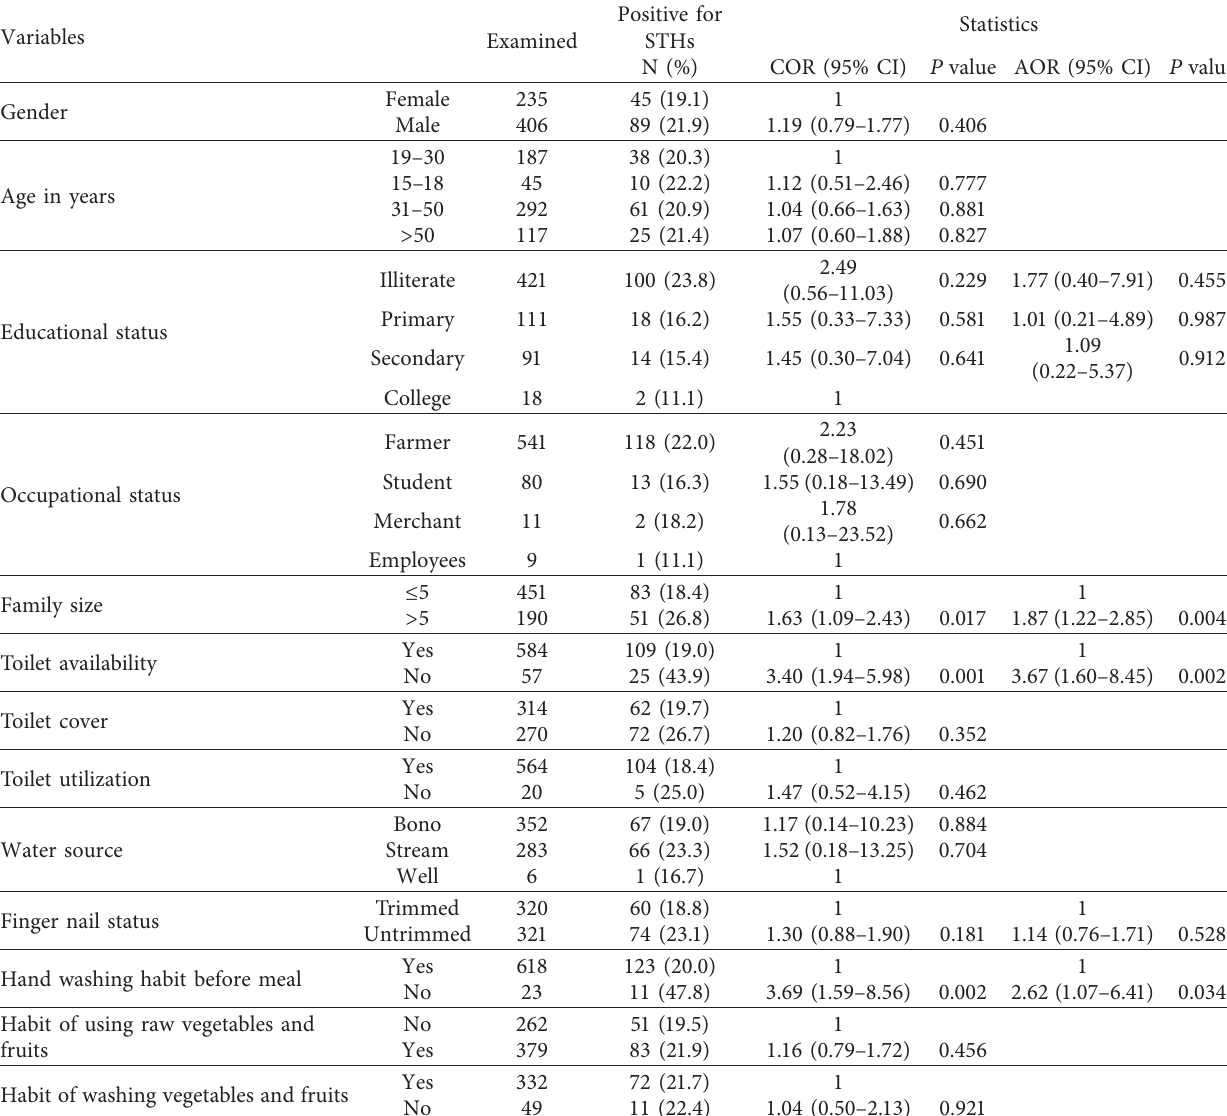
Table 4: The possible potential factors associated with STH infections among adolescents and adults ( n � 641) in Bibugn Woreda, East Gojjam, Ethiopia, from February to September